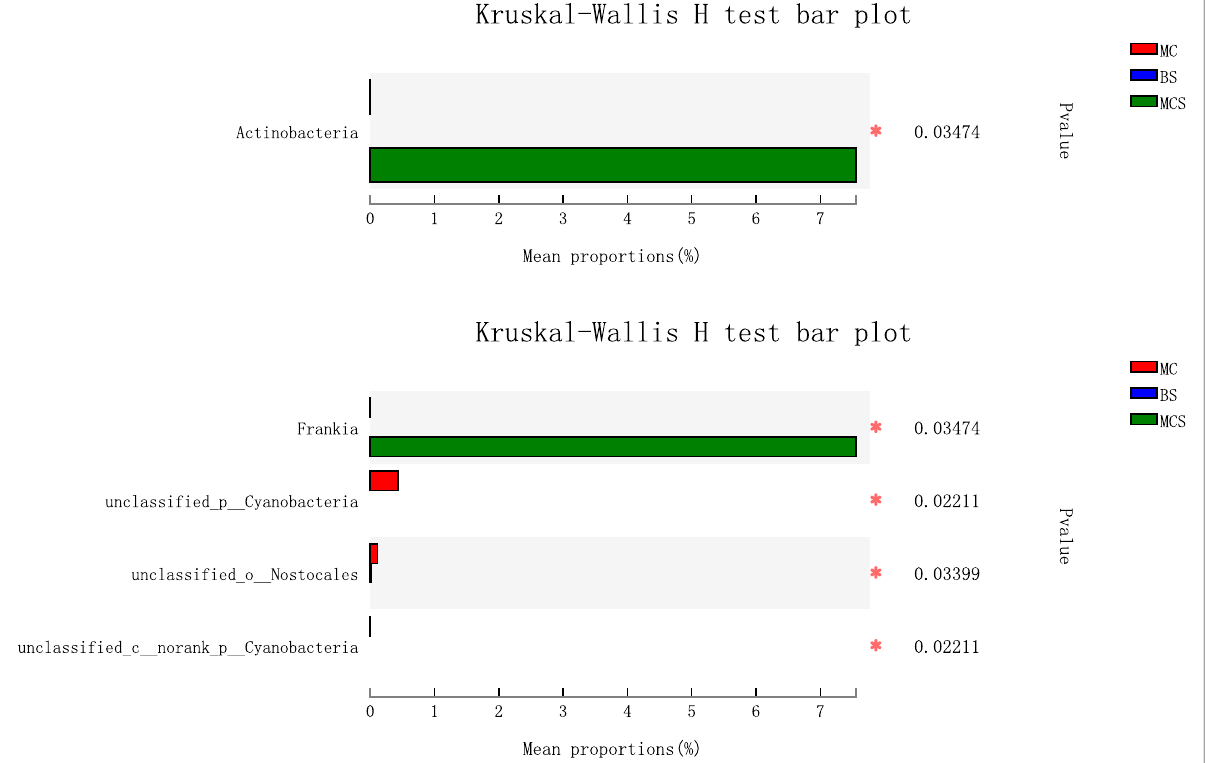
Fig. 6 The Kruskal‑Wallis H test plot at the phylum and genus levels for bacteria. Notes: MC, BS, and MCS are the same as in Fig. 1. Columns of different colors represent different groups. The rightmost is the P value and the corresponding symbol. * P